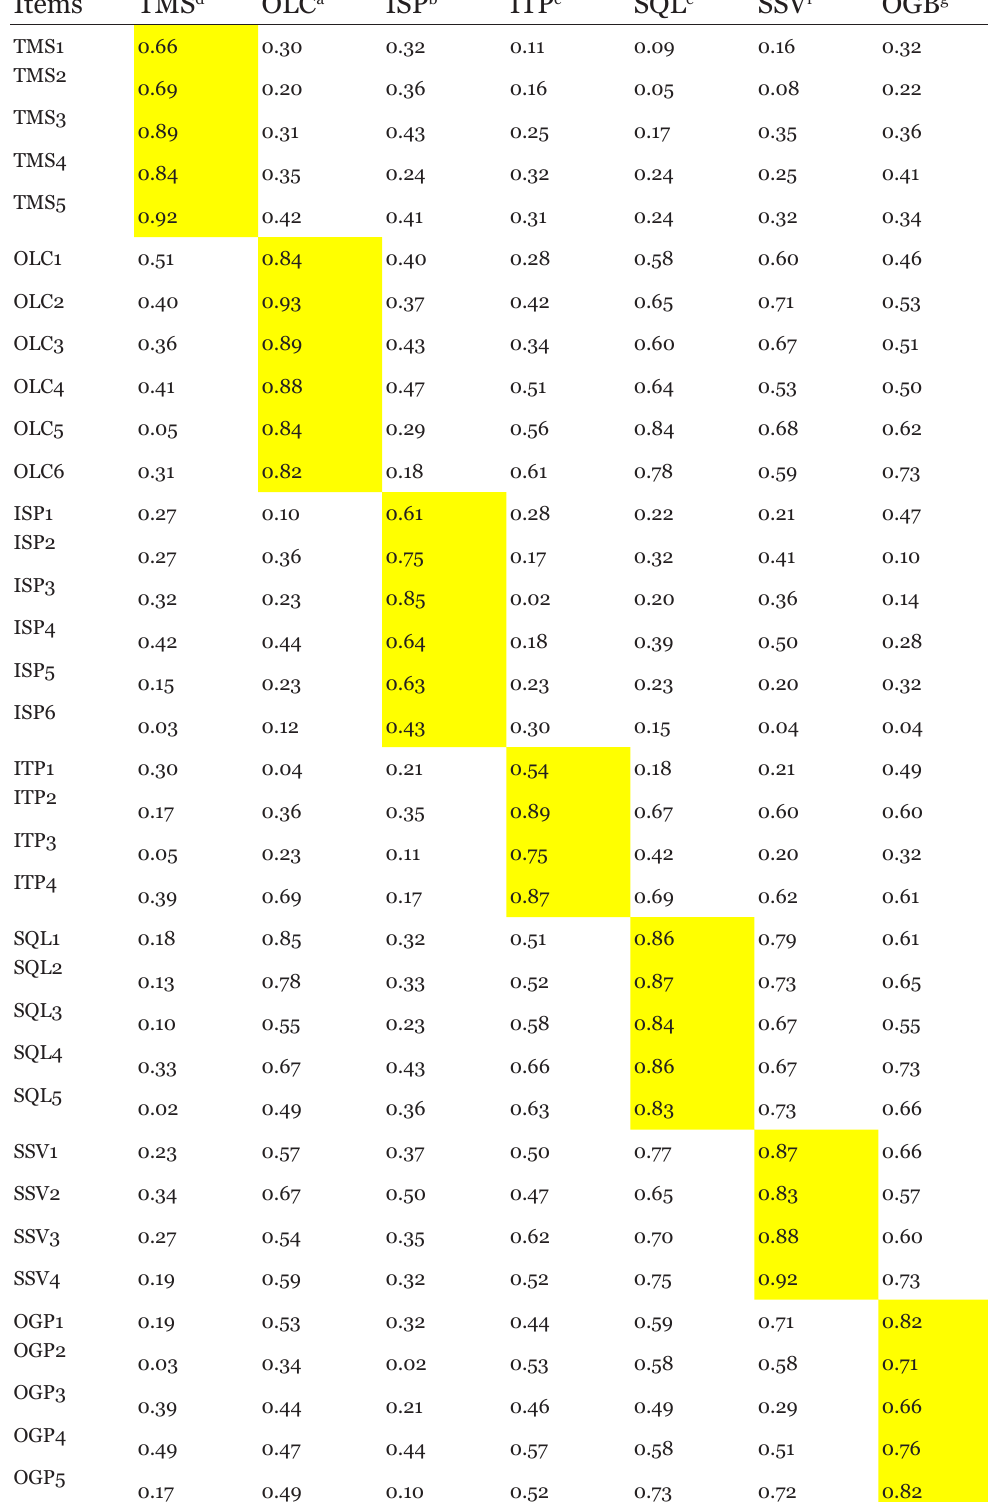
Results of Validity – Cross